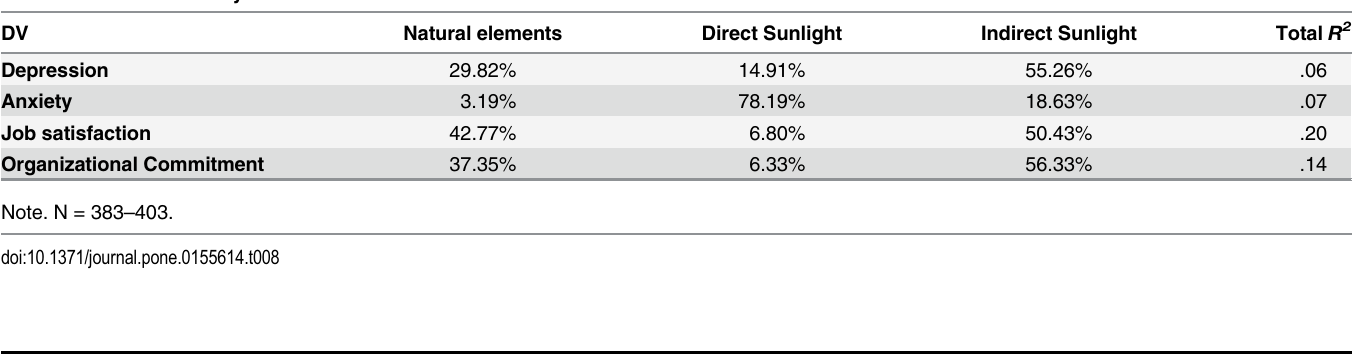
Table 8. Dominance analysis: relative amounts of variance and total R 2